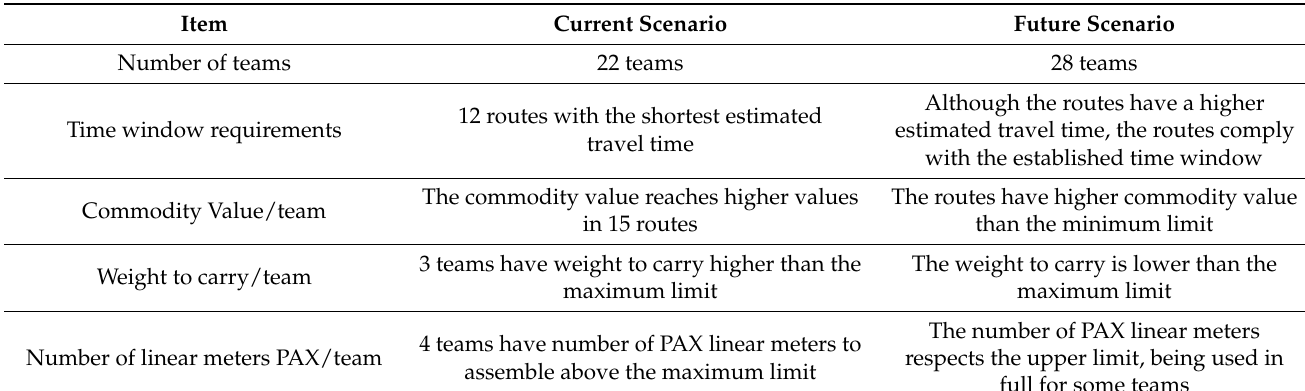
Table 8. Comparison between the current and future